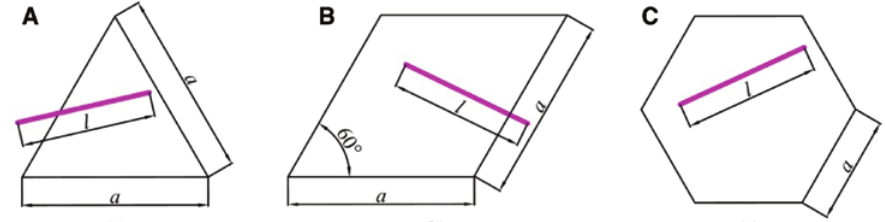
Figure 6: Polygonal cells of different crack patterns: (A) triangle, (B) rhombus, and (C) hexagon.